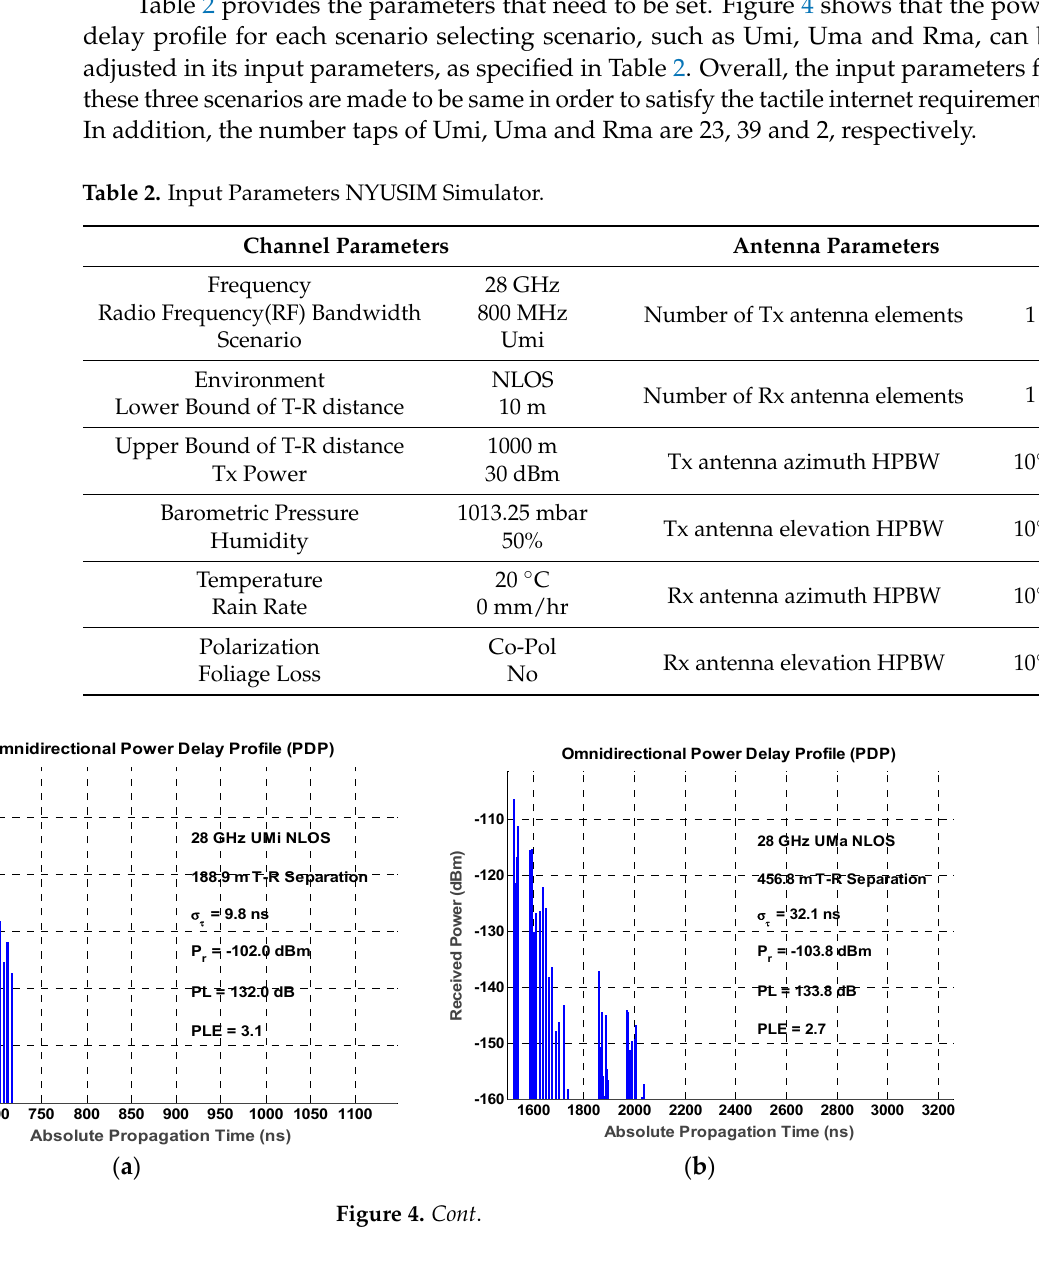
( c ) Figure 4. Power delay profile generated from NYUSIM simulator: ( a ) Umi scenario; ( b ) Uma scenario; ( c ) Rma scenario. 3. Experimental Results Two experimental schemes are defined. The first scheme is to observe the effect of pilot subcarrier spacing under multipath channels using exponential power delay profile. The second scheme is to analyze the influence of NYUSIM model using a power delay profile, as shown in Figure 4. The GFDM properties are adjusted to fulfill the tactile inter- net system requirements. Table 3 indicates the parameters for those two schemes. The Monte-Carlo method is applied for evaluating SER. Table 3. Experimental setup parameters. First scheme